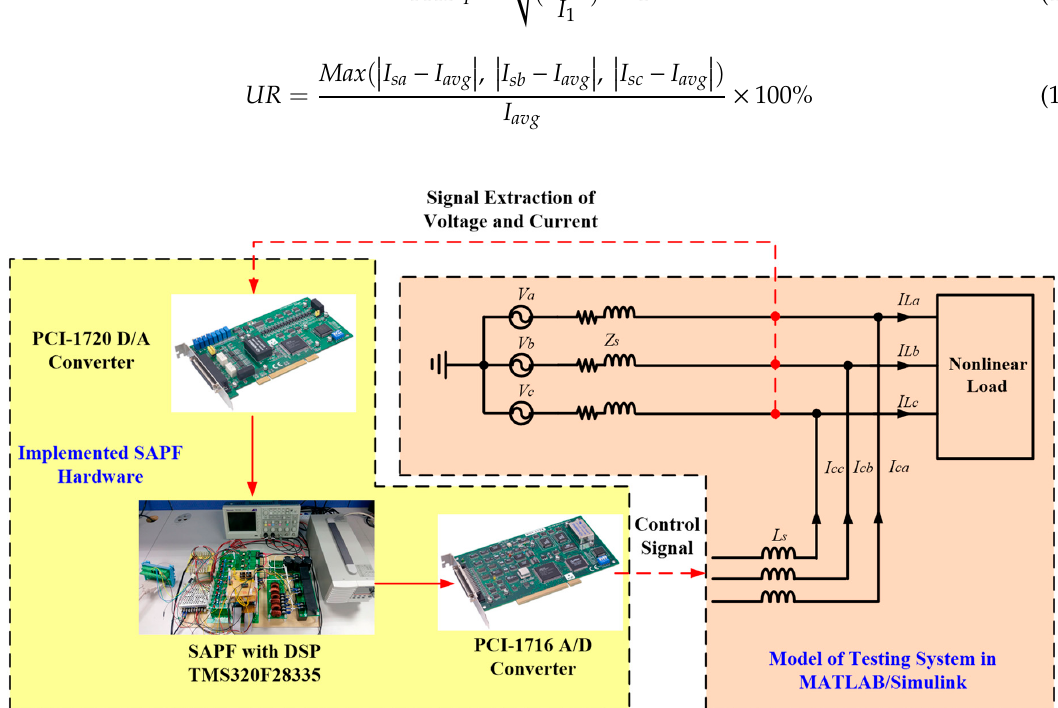
Figure 5. Hardware-in-the-loop (HIL) mechanism for the experimental setup.